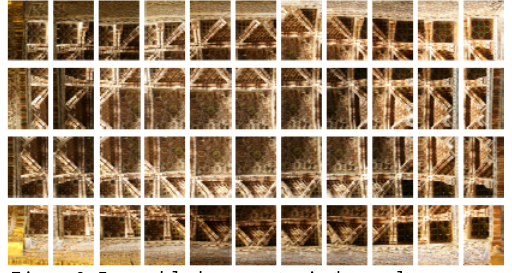
Figure 9. Image block geometry in the vault survey.